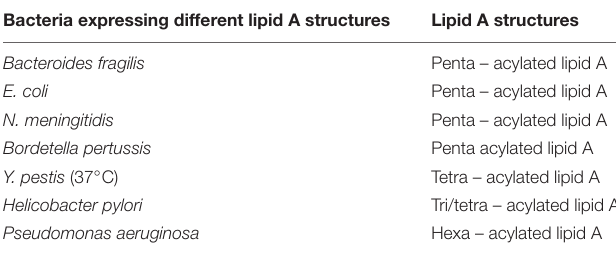
TABLE 2 | The different lipid A structures expressed by bacteria. Bacteria expressing different lipid A